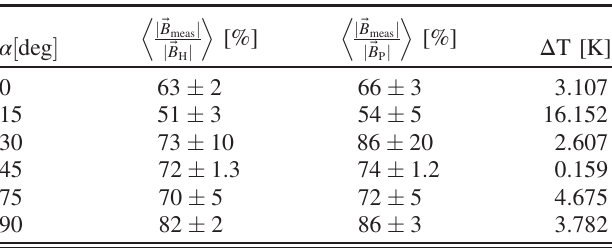
TABLE III. Estimated fraction of trapped flux and its standard variation under the assumption of homogeneous trapping j ⃗ B j for different angles of the applied and perpendicular trapping j P field. The temperature difference of the top and bottom Cernox sensors on the cavity when the lower sensor is at 9.2 K is quoted in the last column.